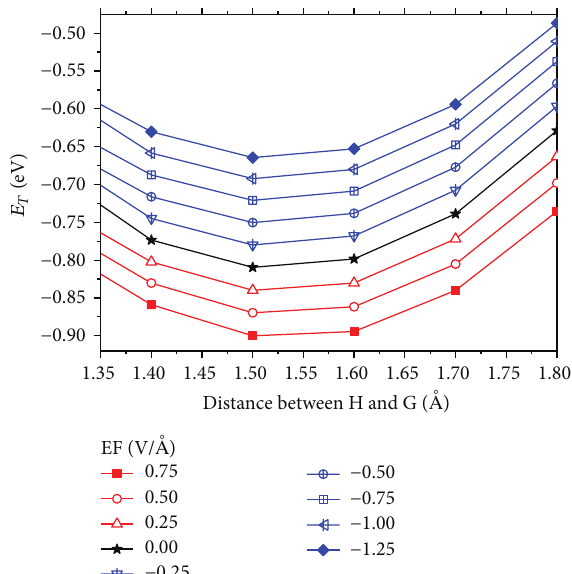
Figure 6: Total energy ( 𝐸 𝑇 ) versus distance between H and G.